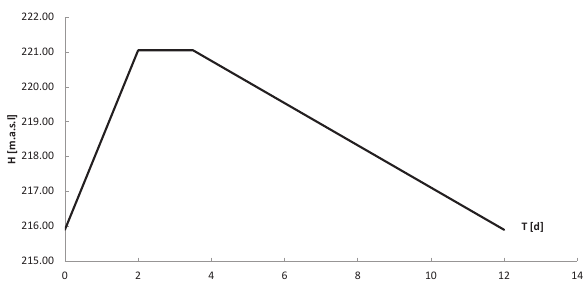
Figure 4: Flood wave used in real – case examples.